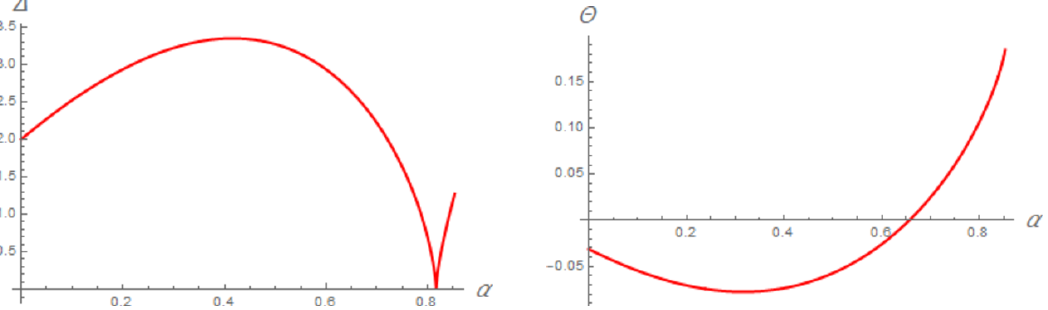
p 2 = 3, while (cid:2) is positive